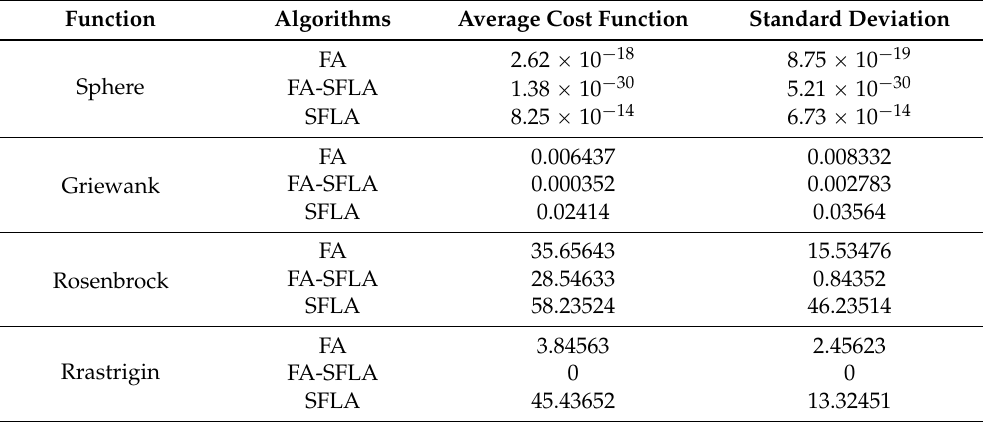
Table 3. Simulation results under three optimization